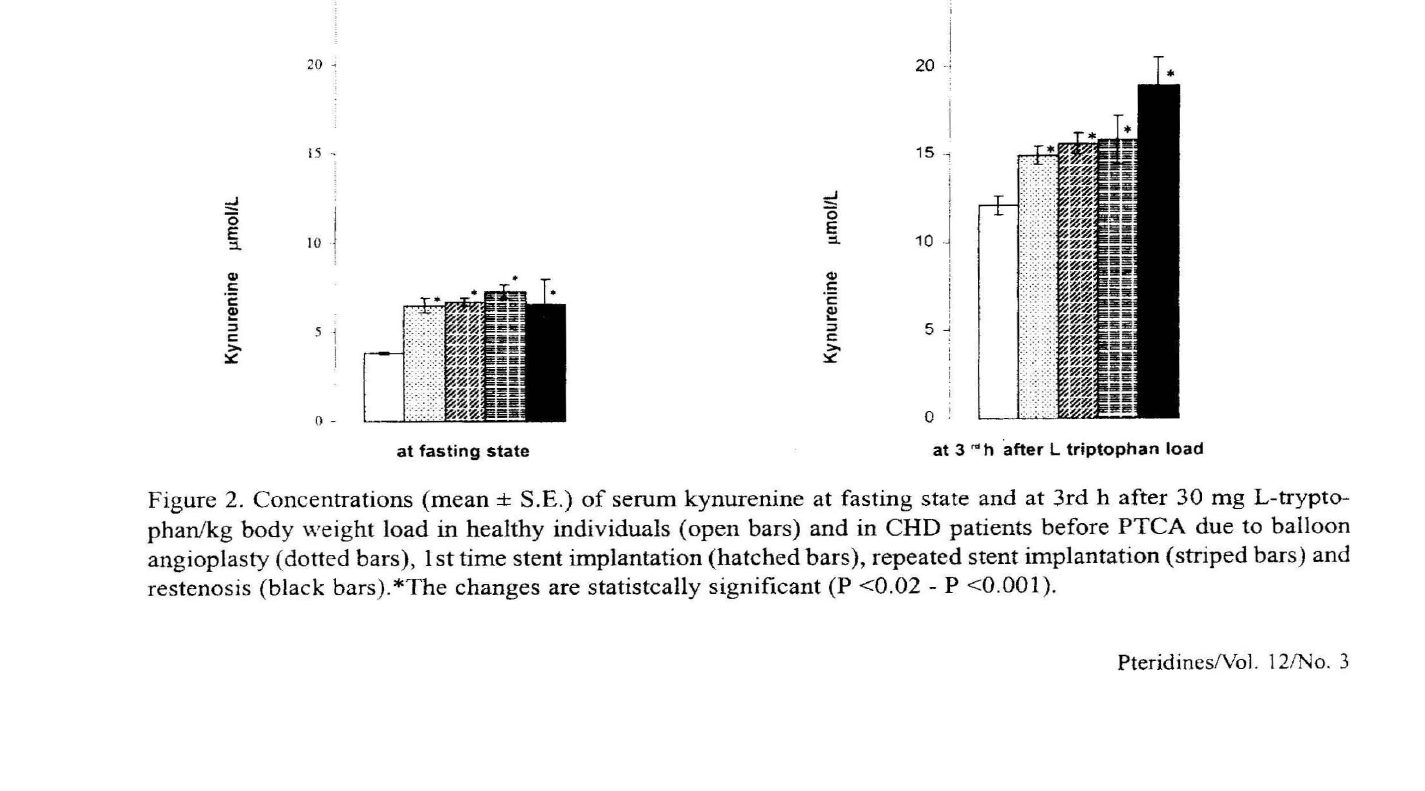
Fig.2). In cases with restenosis tgroup 1\' (,f cr. :-.' patients) an increase of average homocysteln~ .11:2